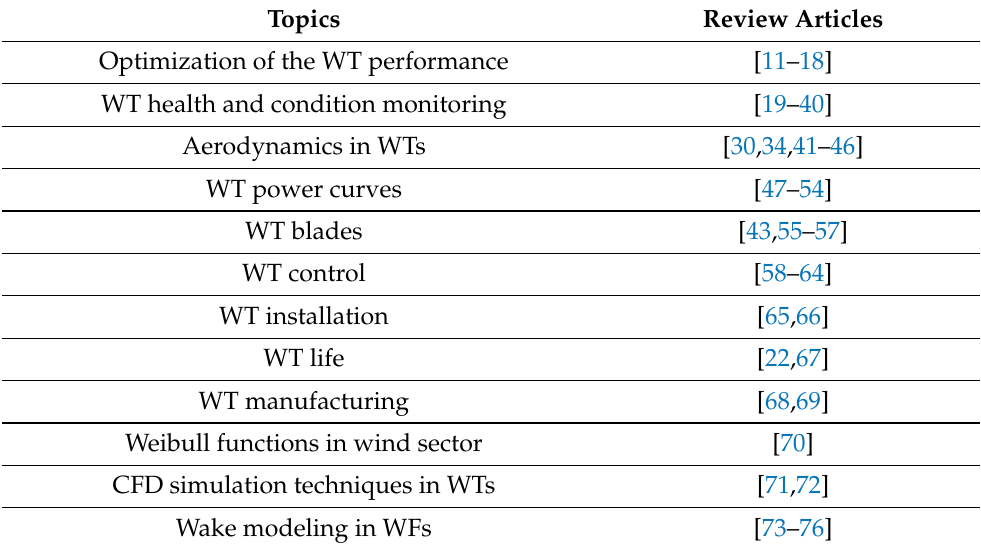
Table 1. Several topics related with wind turbines (WTs) and wind farms (WFs) and corresponding review